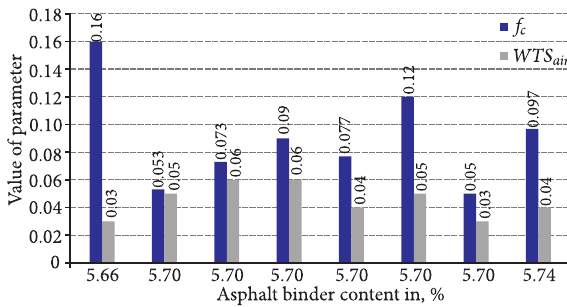
Fig. 6. Comparison of results of cyclic compression test f c and